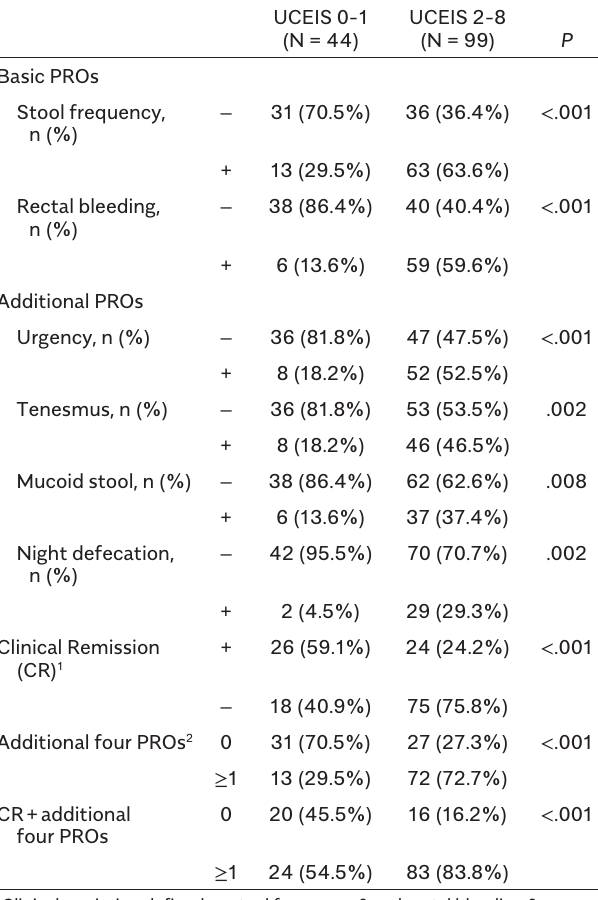
Supplementary Table 3. Of note, upon sensitivity analy-